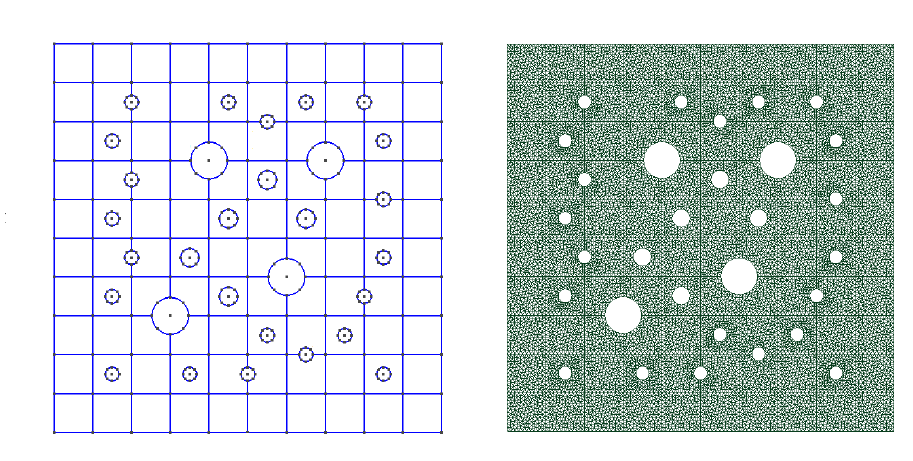
Figure 7. Computational domain with coarse ( left ) and fine ( right )